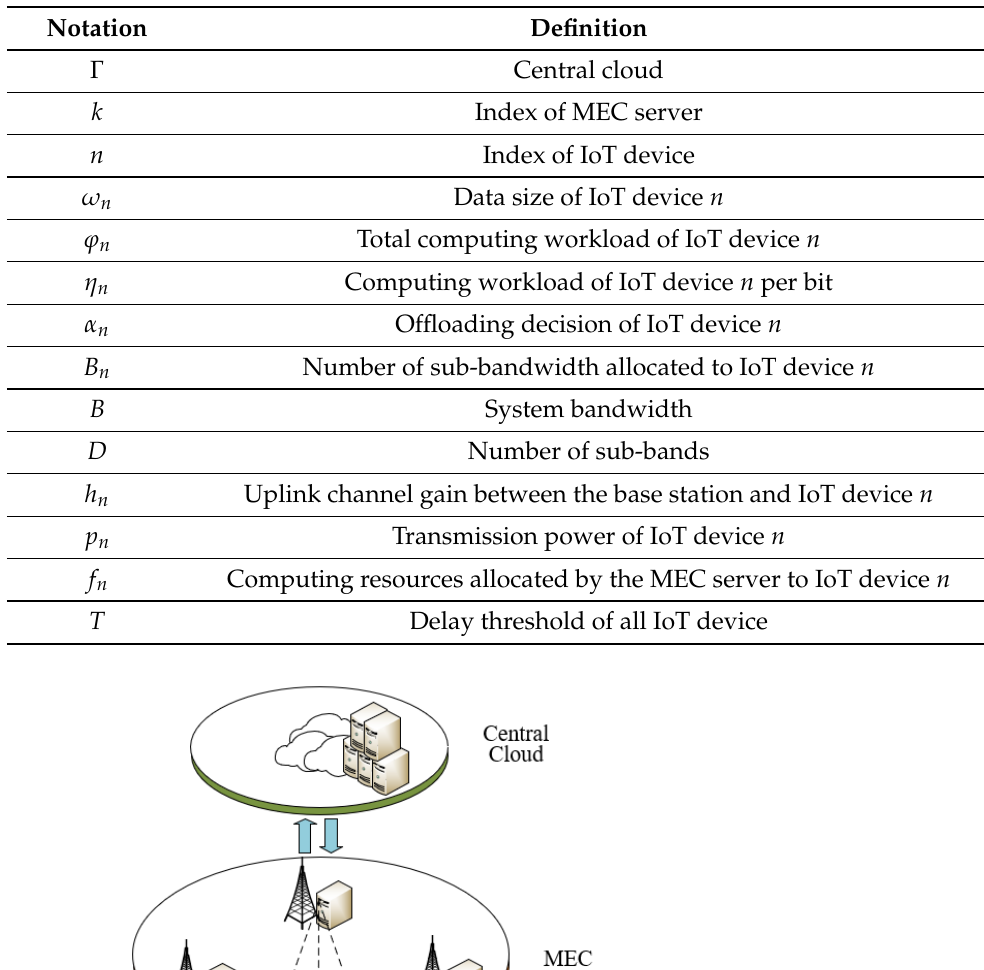
Table 1. Parameter descriptions.